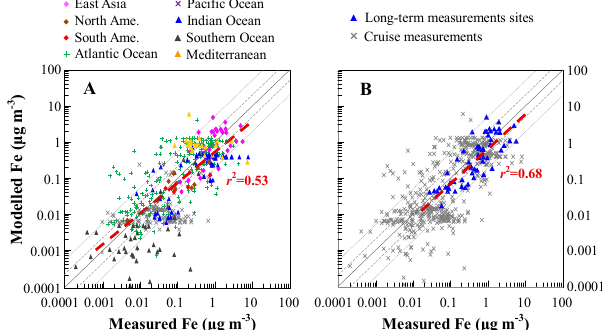
Figure 7 Figure 7. Comparisons of modelled and observed Fe concentrations by region (a) and measuring type (b) . The modelled concentrations are averaged for the months in the year of measuring. The fitted curves for all stations in (a) and long-term measurement stations in (b) are shown as red dashed lines, with coefficients of determination ( r 2 ) listed. The 1:1 (solid), 1:2 and 2:1 (dashed), and 1:5 and 5:1 (dotted) lines are shown.